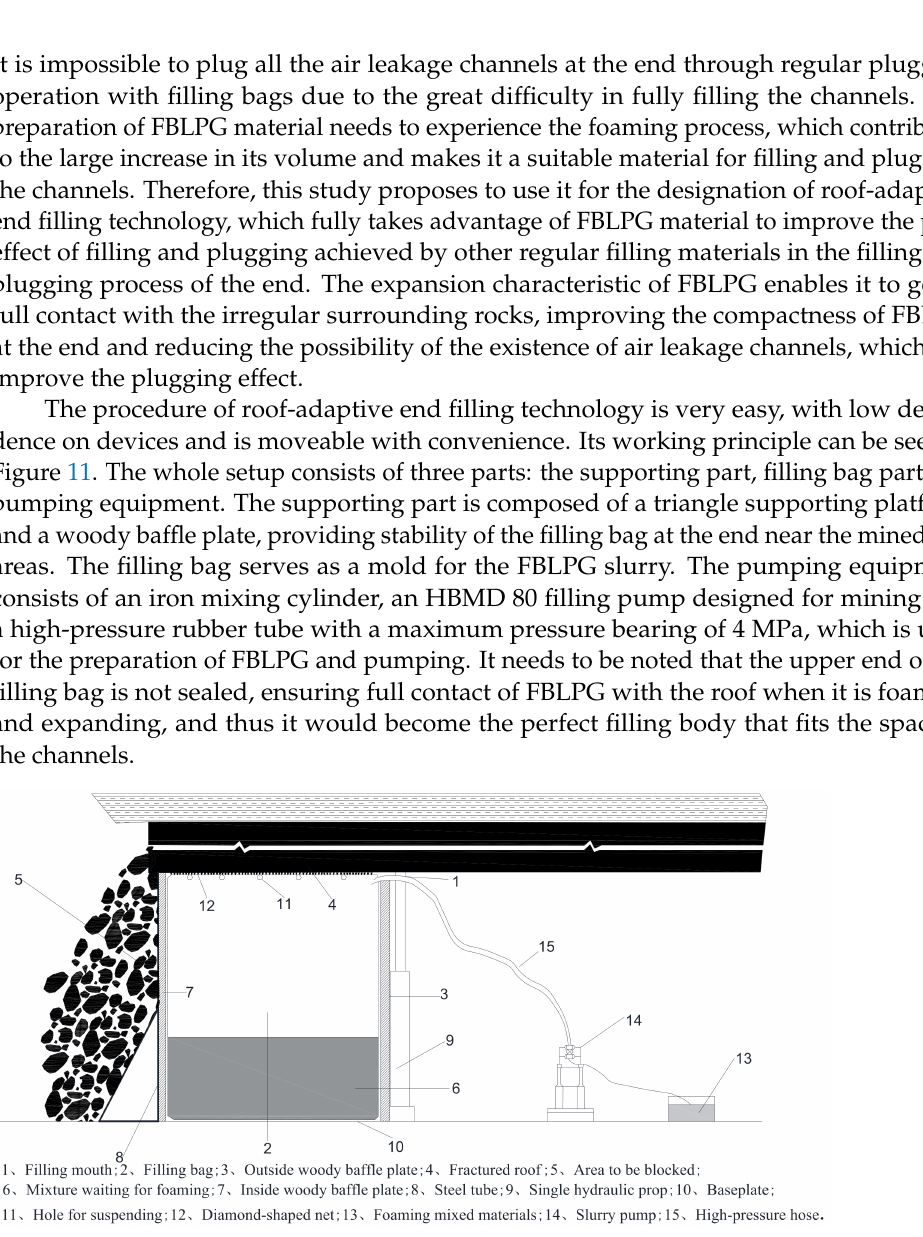
Figure 11. Schematic diagram of roof-adaptive end filling